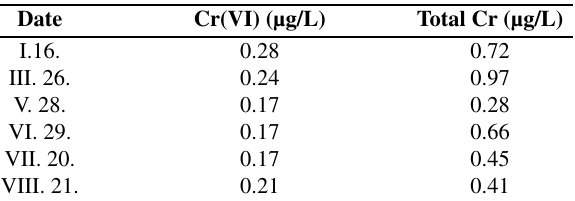
Table 4. Bulgarian Black Sea water samples 2016 ( n = 3, RSD ≤ 3%)